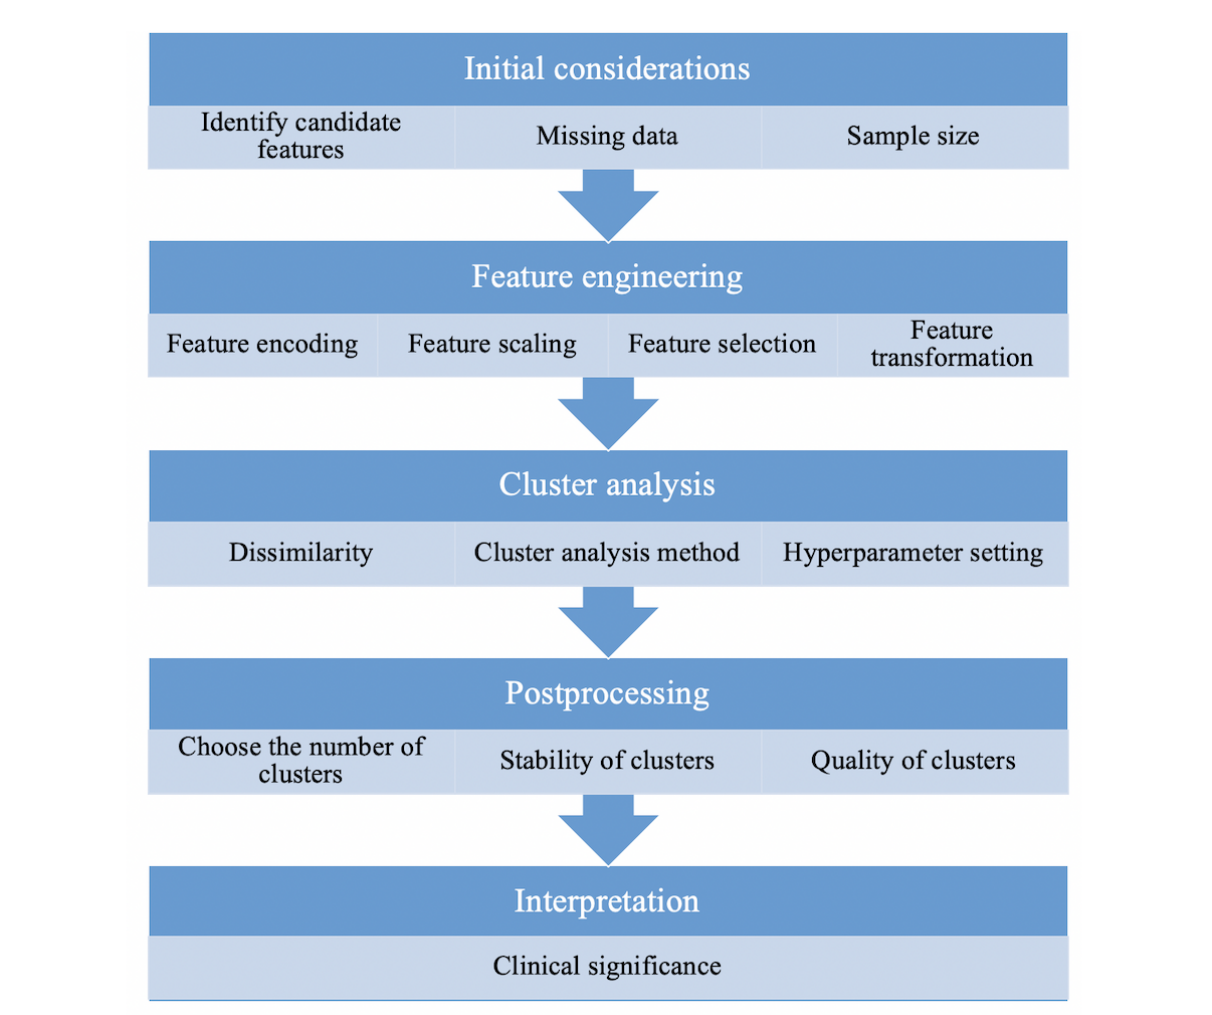
Figure 1. Schematic of the typical cluster analysis